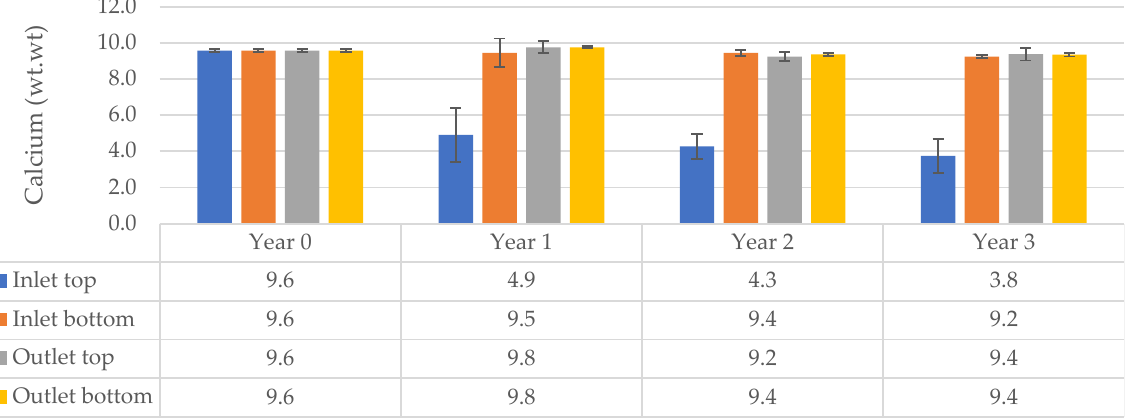
Figure 7. Percentage calcium in sand from cores taken from biosand reactors treating winery wastewater for three years. Table 2. Percentage calcium in sand from cores taken from biosand reactors treating winery wastewater. Position Inlet (ca